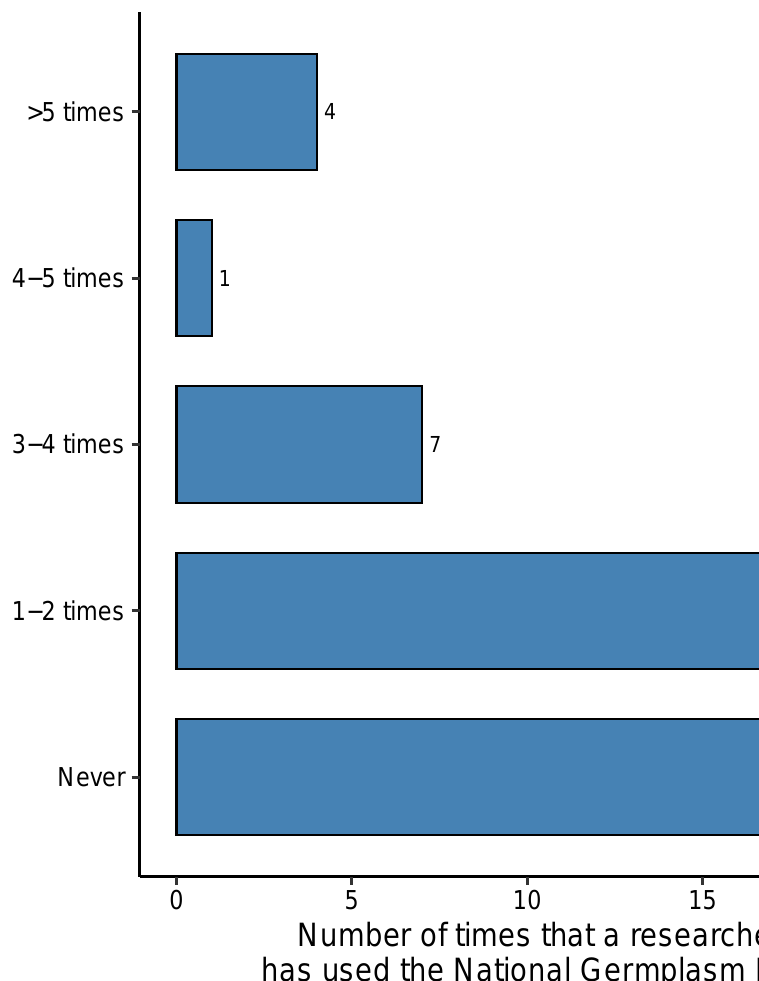
Figure 4. The number of times that researchers working on plant breeding and plant genetic resources from A GROSAVIA have requested germplasm from the National Plant Germplasm Bank of Colombia in the last ten